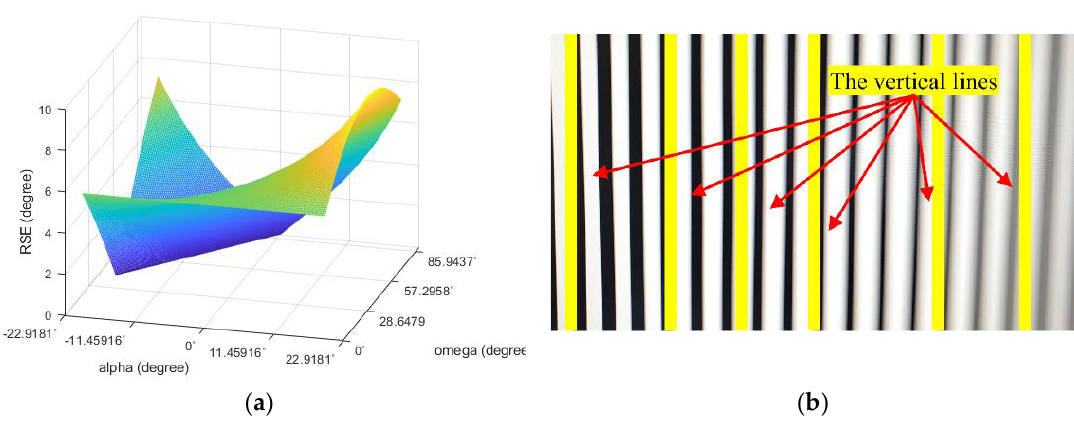
Figure 11. RSE occurrence test result: ( a ) simulation data using arbitrarily set parameters and ( b ) the image taken when the movement of the camera has a certain angle to the image plane.